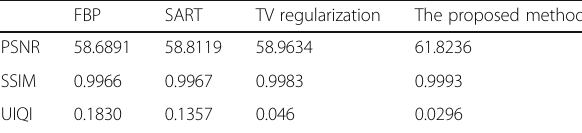
Table 3 Comparison of image evaluation parameters of different reconstruction algorithms (head